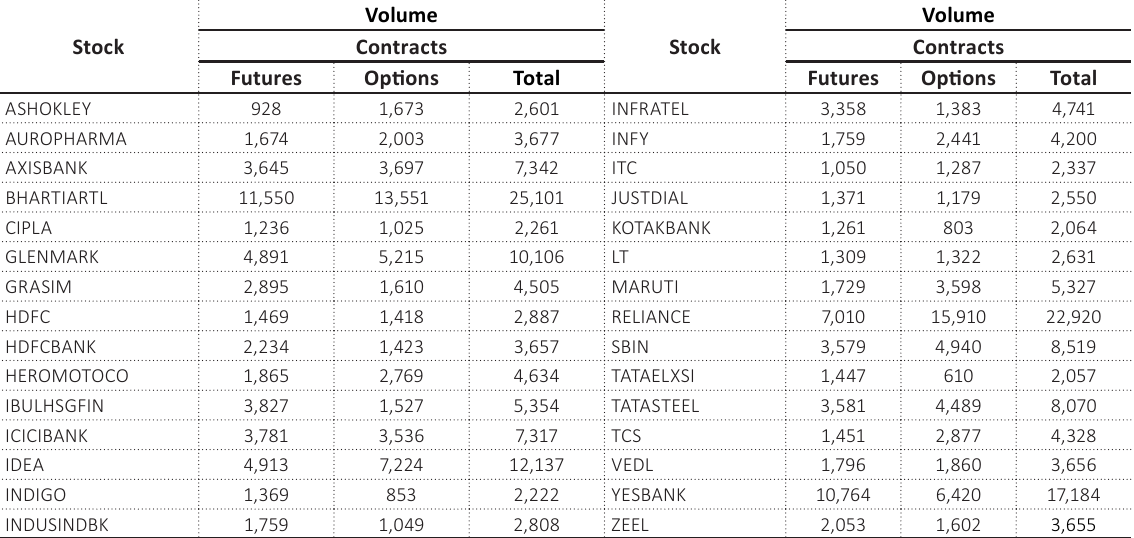
Table 1. List of selected stocks and their